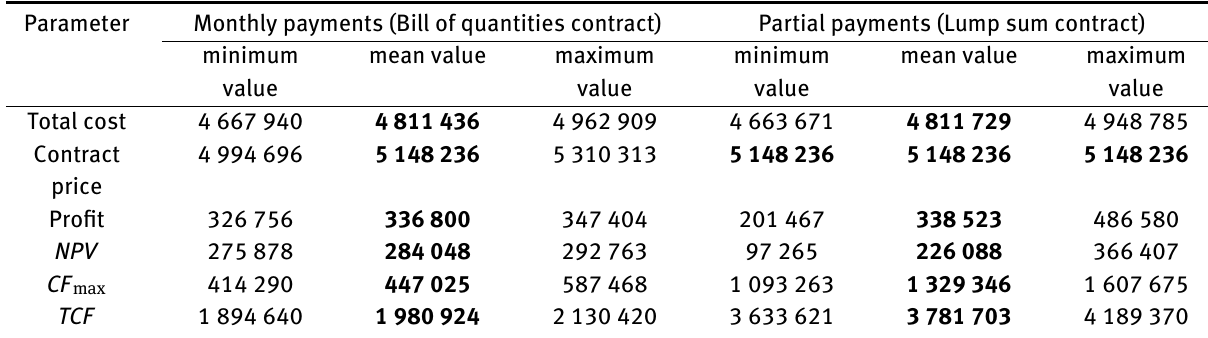
Table 5: Influence of random variations of works’ quantities within + − 5% onto financial parameters of construction project. Parameter